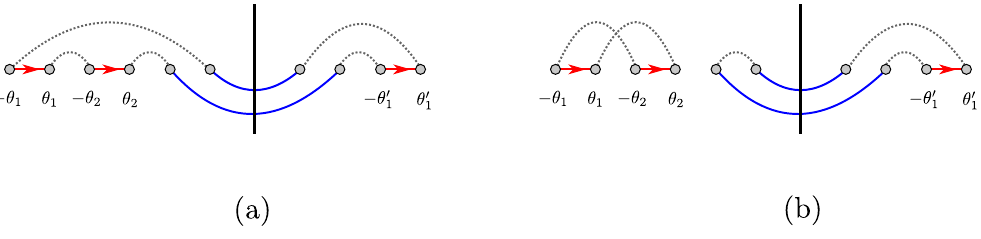
(cid:2) F T . Each dashed line represent a term 6 4